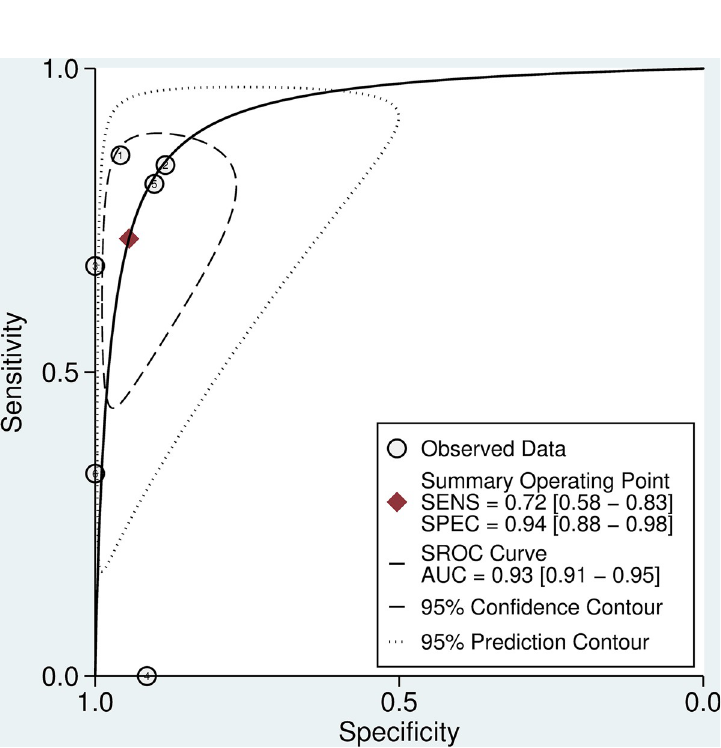
Fig 3. SROC curve for 20WBCT at detecting coagulopathy. SROC curves for 20WBCT at detecting mild coagulopathy defined as INR > 1 � 4.